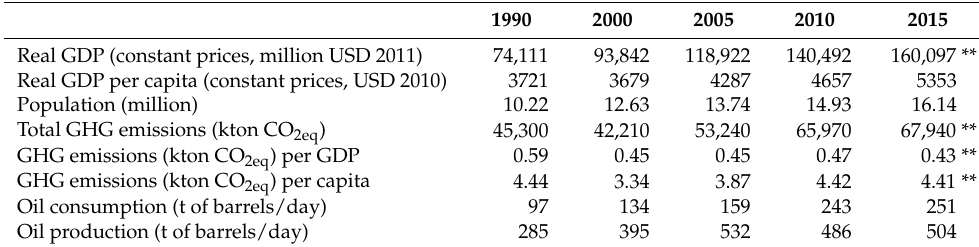
Table 2. Ecuador’s GDP, population growth, GHG emissions * and oil production and consumption in